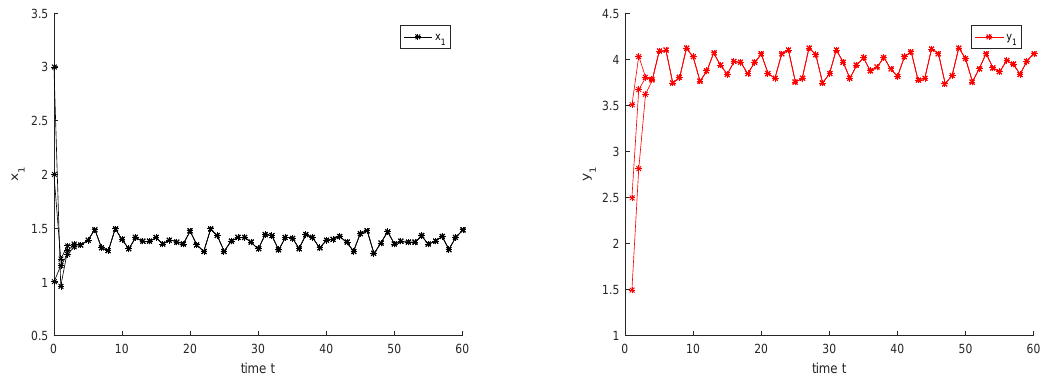
Figure 1: Dynamic behaviors of the solutions ( x * (2, 3) and (3, 5) , respectively.